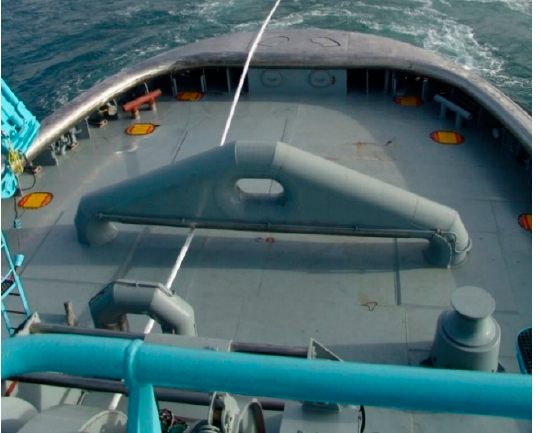
Figure 13. Wide staple of Escort Voith Water Tractor Tug “Tenax” with water spray cooling for escort towing with a high modulus polyethylene (HMPE) towline. The contact surfaces of both the staple and all around the cap rail are made of a highly polished stainless steel. Photo: Authors.